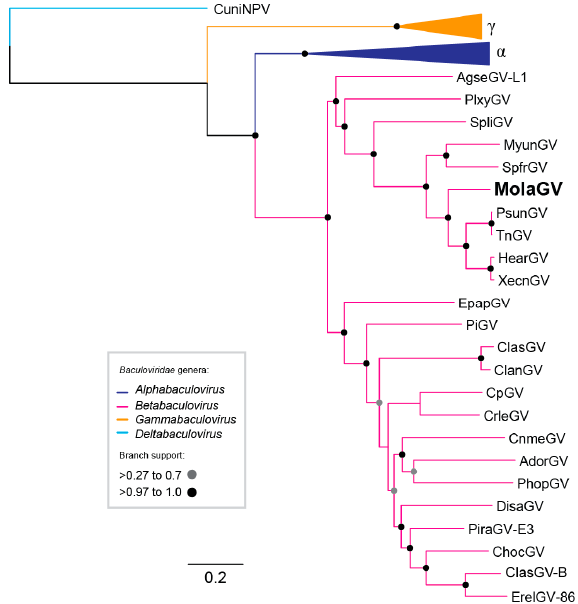
Figure 1. Maximum-likelihood tree for the Baculoviridae . The phylogenetic inference was based on the concatenated amino acid sequences of the 38 core proteins identified in all baculovirus genomes sequenced so far. We collapsed species from the genera Gammabaculovirus (orange, γ ) and Alphaphabaculovirus (dark blue, α ). Culex nigripalpus nucleopolyhedrovirus (CuniNPV) roots the tree (light blue). Mocis latipes granulovirus (MolaGV) (boldface) is a betabaculovirus and a sister species of the cluster formed by Pseudaletia unipuncta granulovirus (PsunGV), Trichoplusia ni granulovirus (TnGV), Xestia c-nigrum granulovirus (XecnGV), and Helicoverpa armigera granulovirus (HearGV) with high support.